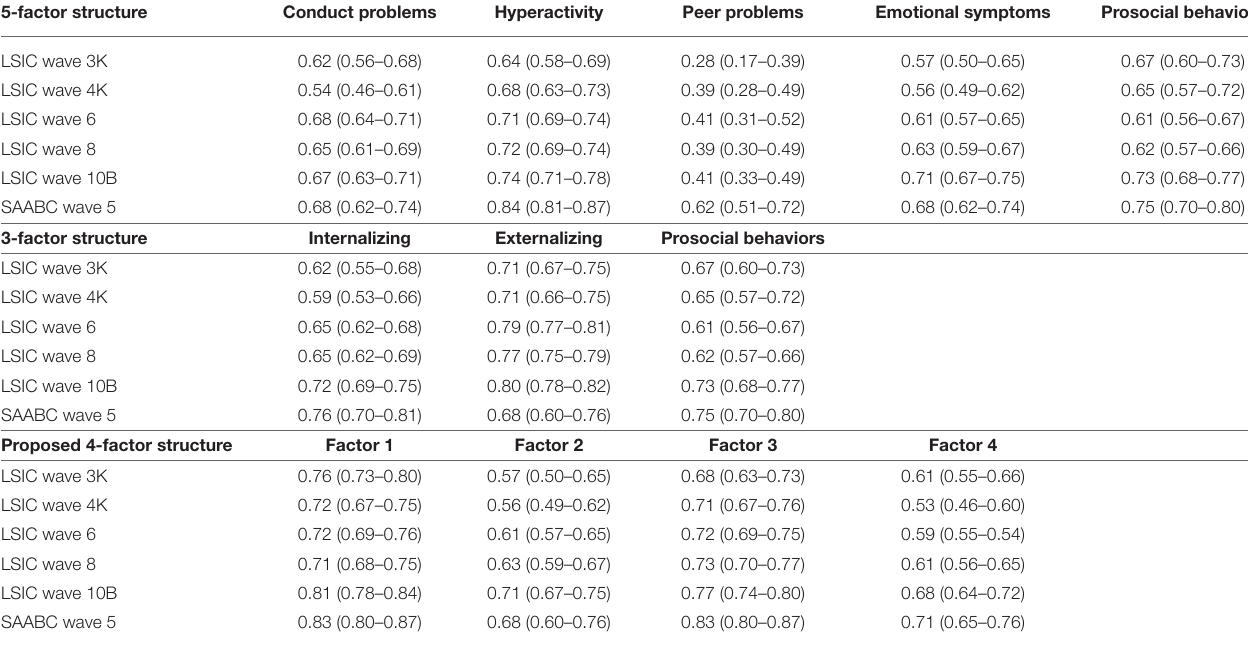
TABLE 5 | Reliability of the SDQ